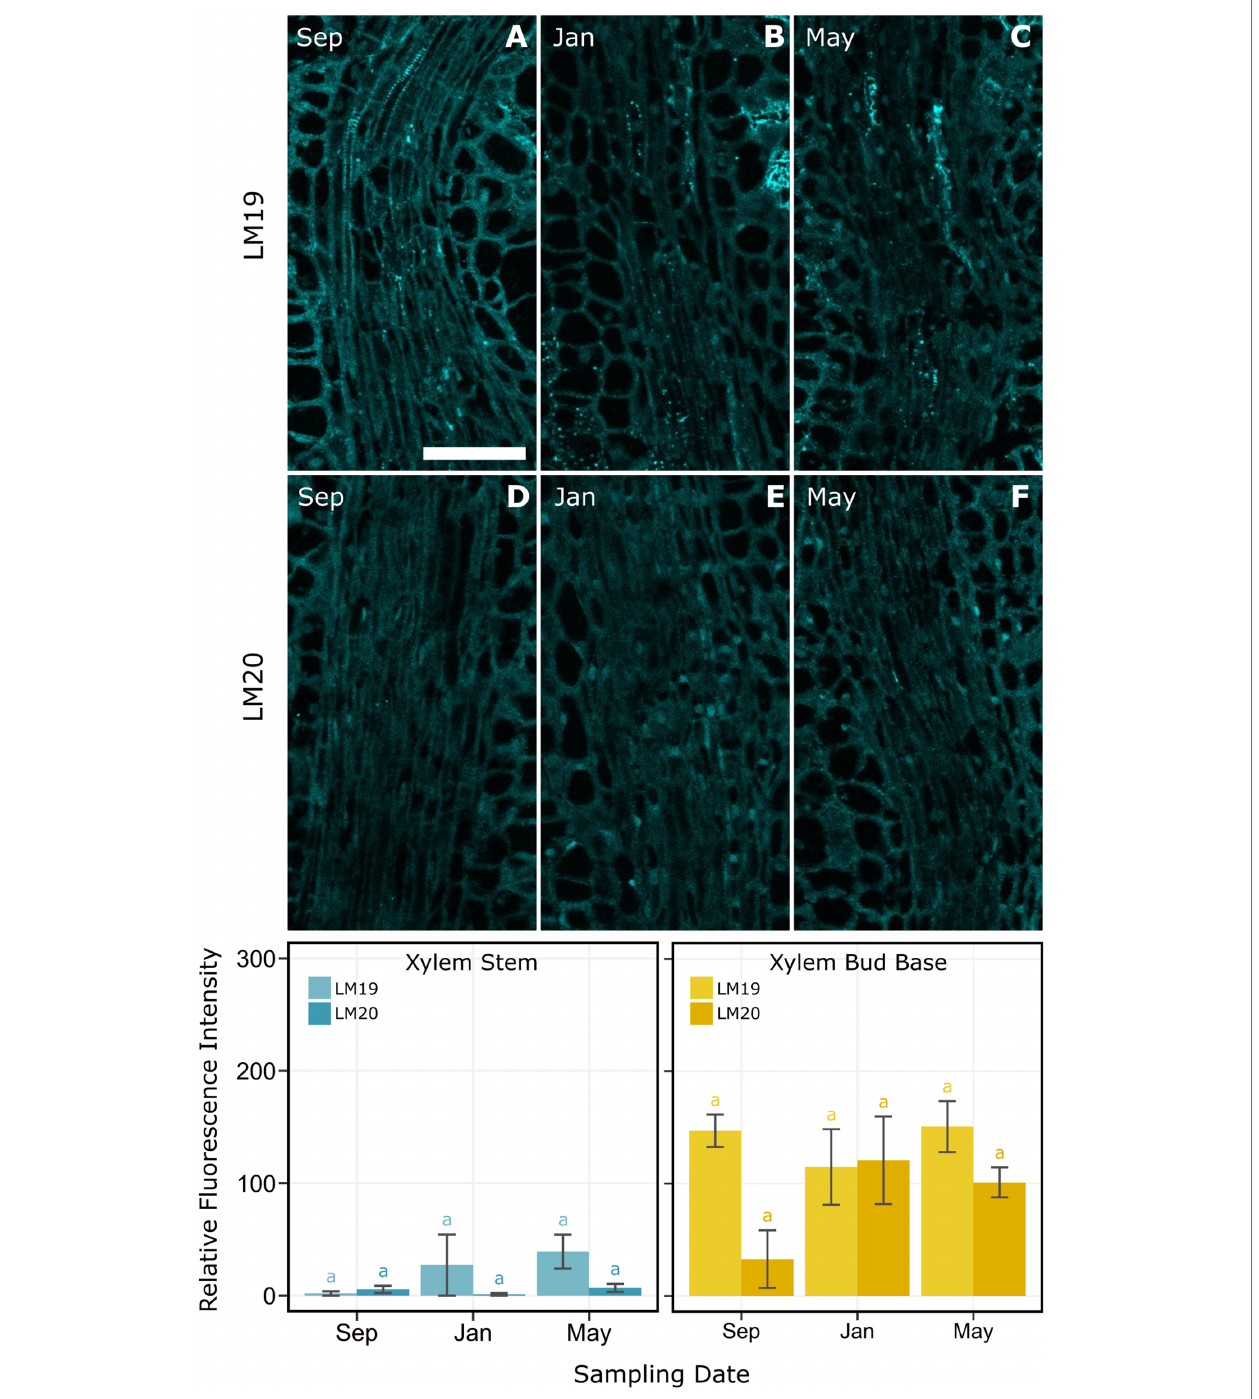
FIGURE 8 | Indirect immunolocalization with antibodies (A–C) LM19 (de-methyl-esterified form) and (D–F) LM20 (methyl-esterified form) targeting homogalacturonan in xylem and xylem parenchyma cells of Vaccinium macrocarpon . Images of samples from (A,D) September, (B,E) January, and (C,F) May. Bar plot for the average relative fluorescence intensity for xylem and xylem parenchyma cells in the stem zone (bottom left). Bar plot for the average relative fluorescence intensity for xylem and xylem parenchyma cells in the bud base (bottom right). Lower case letters represent significant difference among the means of the same antibody and tissue in each plot. Vertical lines represent the SE of the mean. Scale bar = 50